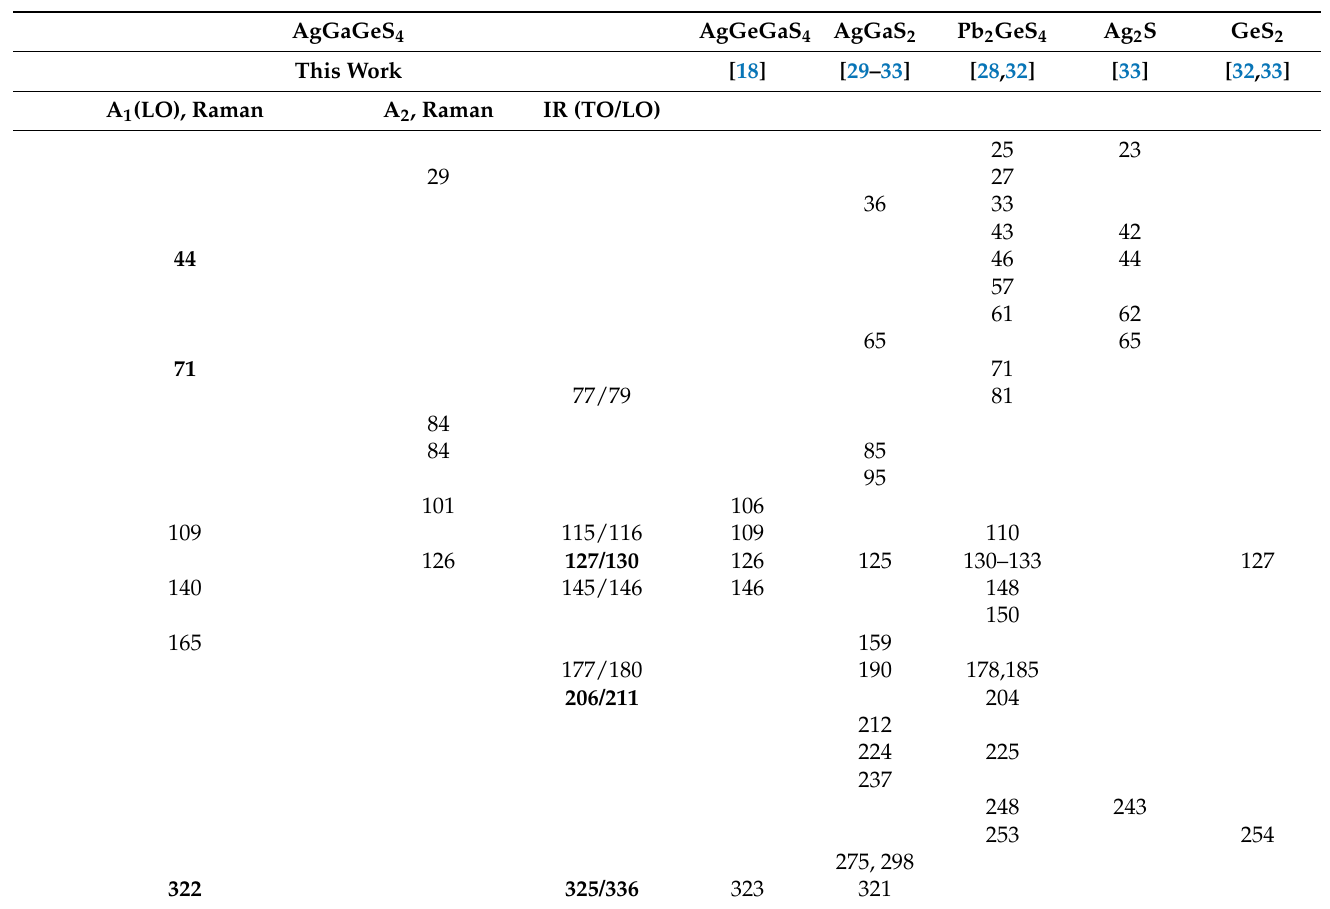
Figure 4. ( a ) Temperature-dependent Raman spectra of AgGaGeS 4 (  exc = 514.5 nm) in the range of 15 K to 265 K. ( b ) The spectra for 15 K to 265 K shown in more detail.